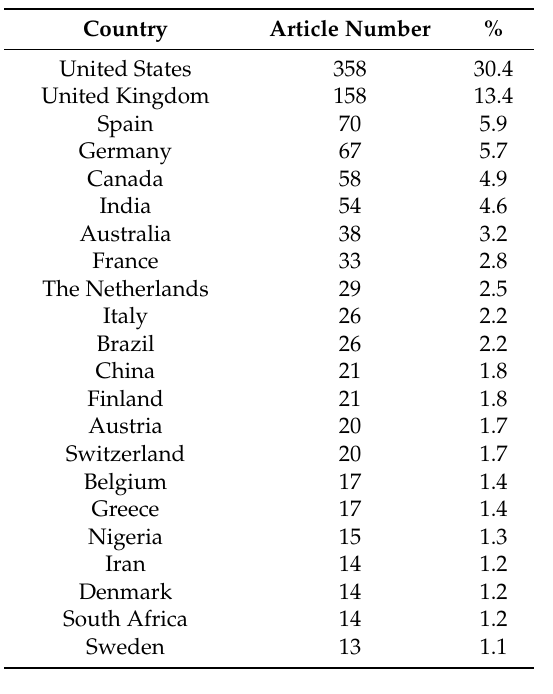
Table 1. Major producing countries on the theme open